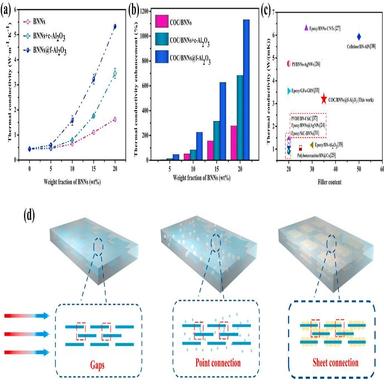
(a) In-plane thermal conductivity of BNNs, BNNs + c-Al2O3 and BNNs@f-Al2O3 filled COC composites; (b) Thermal conductivity enhancement of various composites compared with COC; (c) The thermal conductivity comparation of previous works and this work; (d) The illustration of thermal conductivity enhancement mechanism.